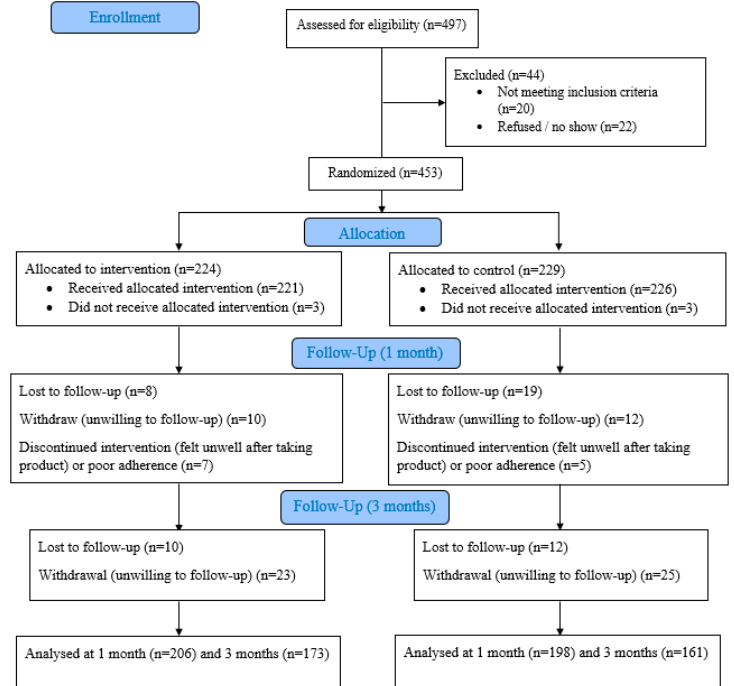
Figure 1. CONSORT Flow diagram .